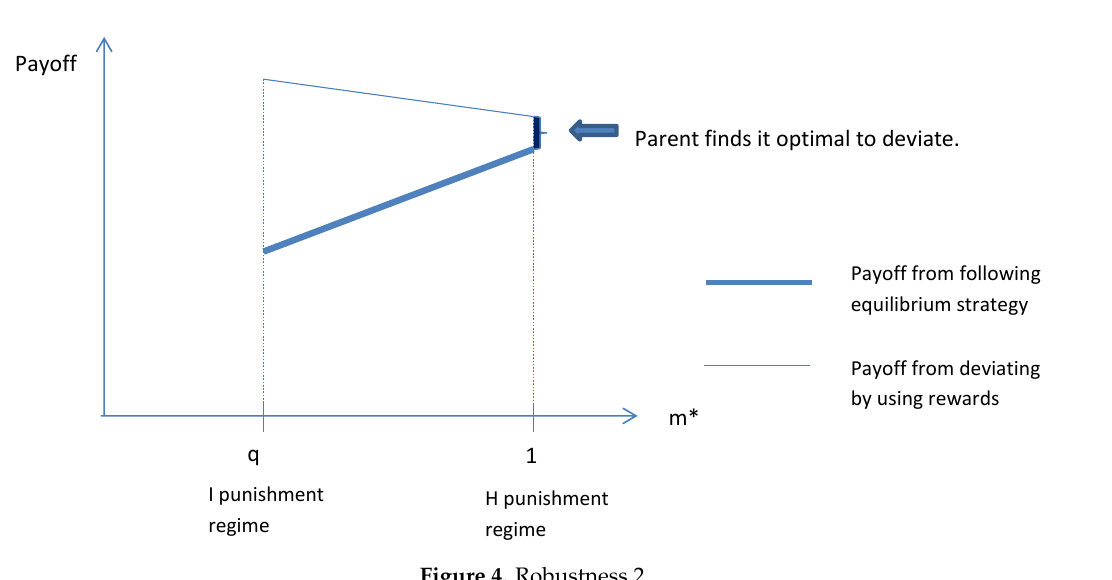
Figure 4. Robustness